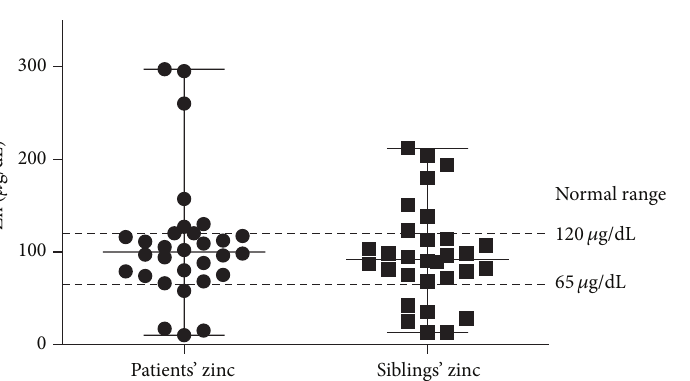
Figure 1: Comparison between serum Zn levels for patients and their corresponding siblings. Median levels were within normal range: 100 𝜇 g/dL (10 𝜇 g/dL–297 𝜇 g/dL) for patients and 92 𝜇 g/dL (13 𝜇 g/dL–212 𝜇 g/dL) for